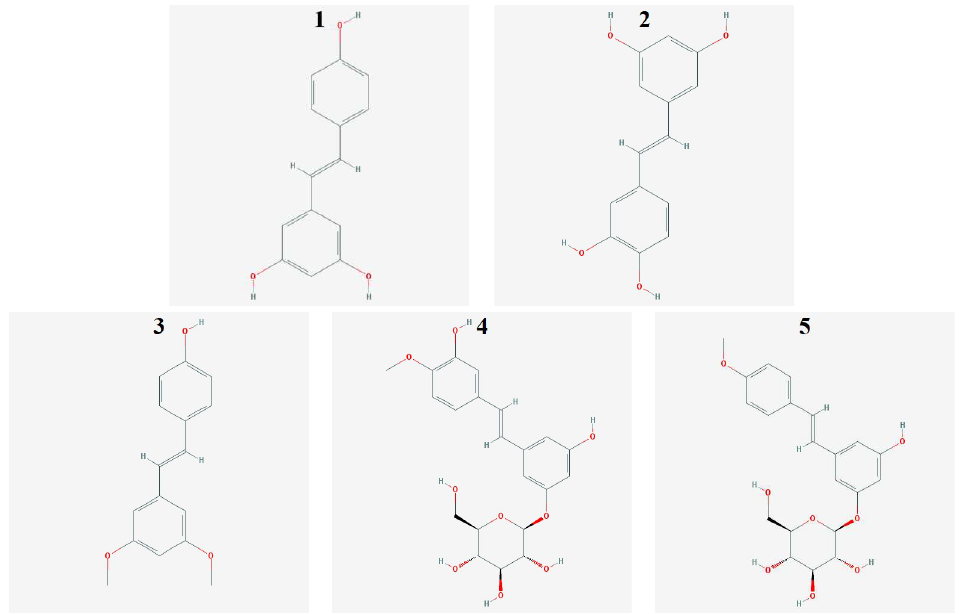
Figure 1. Structural formulas of the stilbene derivatives tested ( 1 - t -Resveratrol, 2 -Piceattanol, 3 -Pterostilbene, 4 -Rhapontycin, 5 -Deoxyrhaponticin).